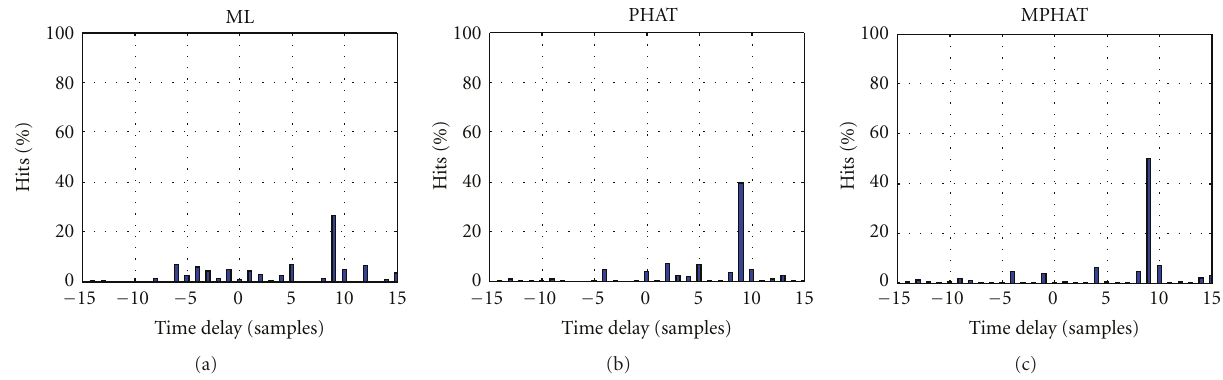
Figure 5: TDE performance in joint noisy and reverberant situations (exact value of TDOA is 9 samples).